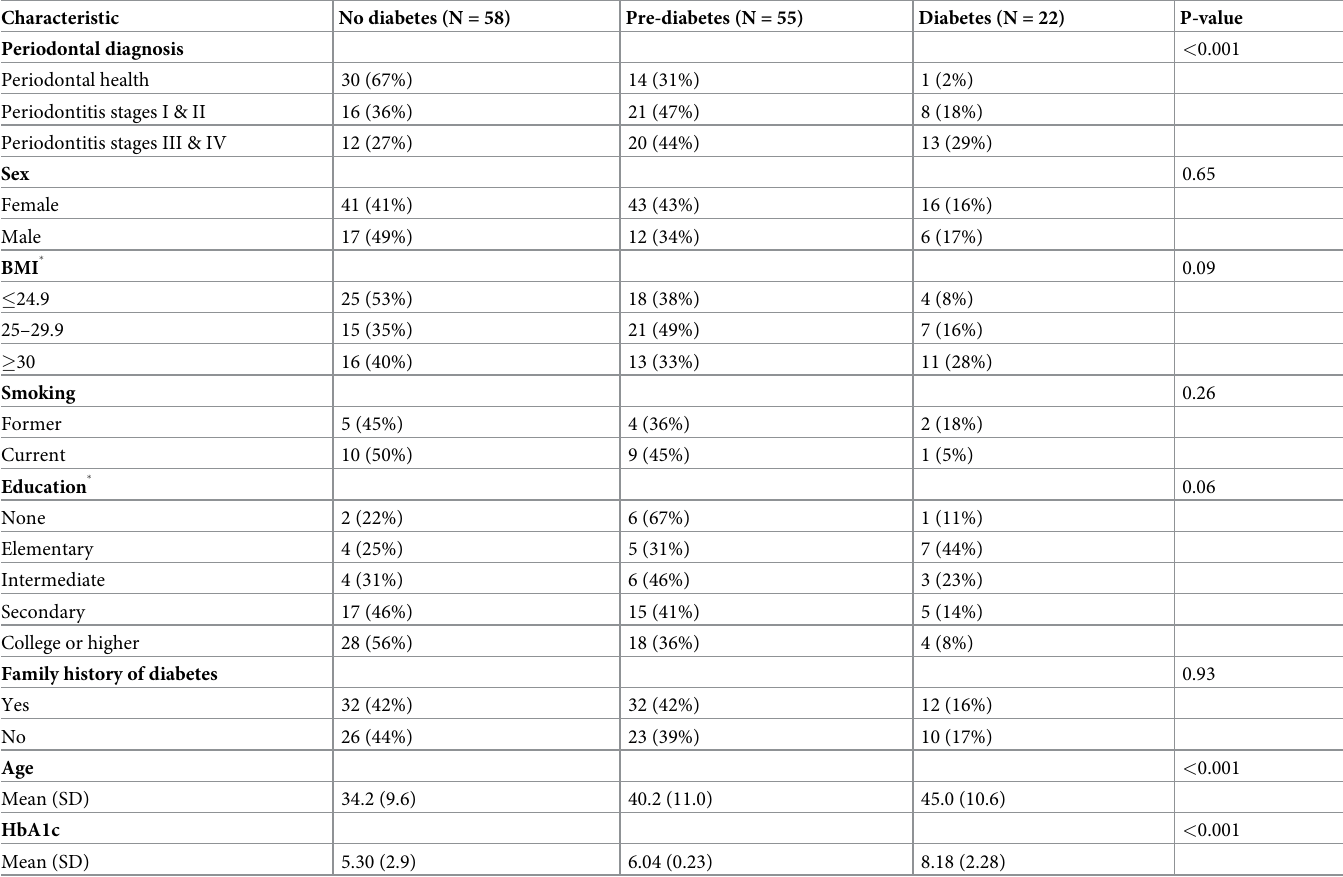
Table 3. Characteristics of the study population by diabetes